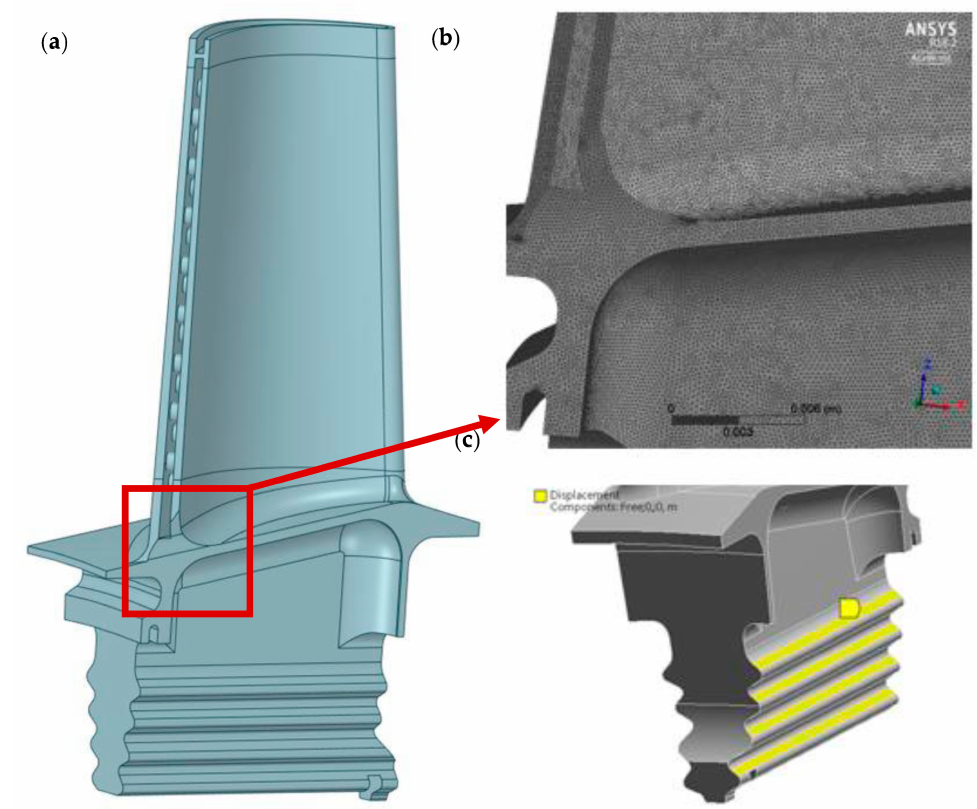
Figure 7. Created 3D CAD model of a high-pressure turbine blade ( a ) with computational mesh density ( b ); fix Boundary Condition on upper surfaces of the blade attachment ( c